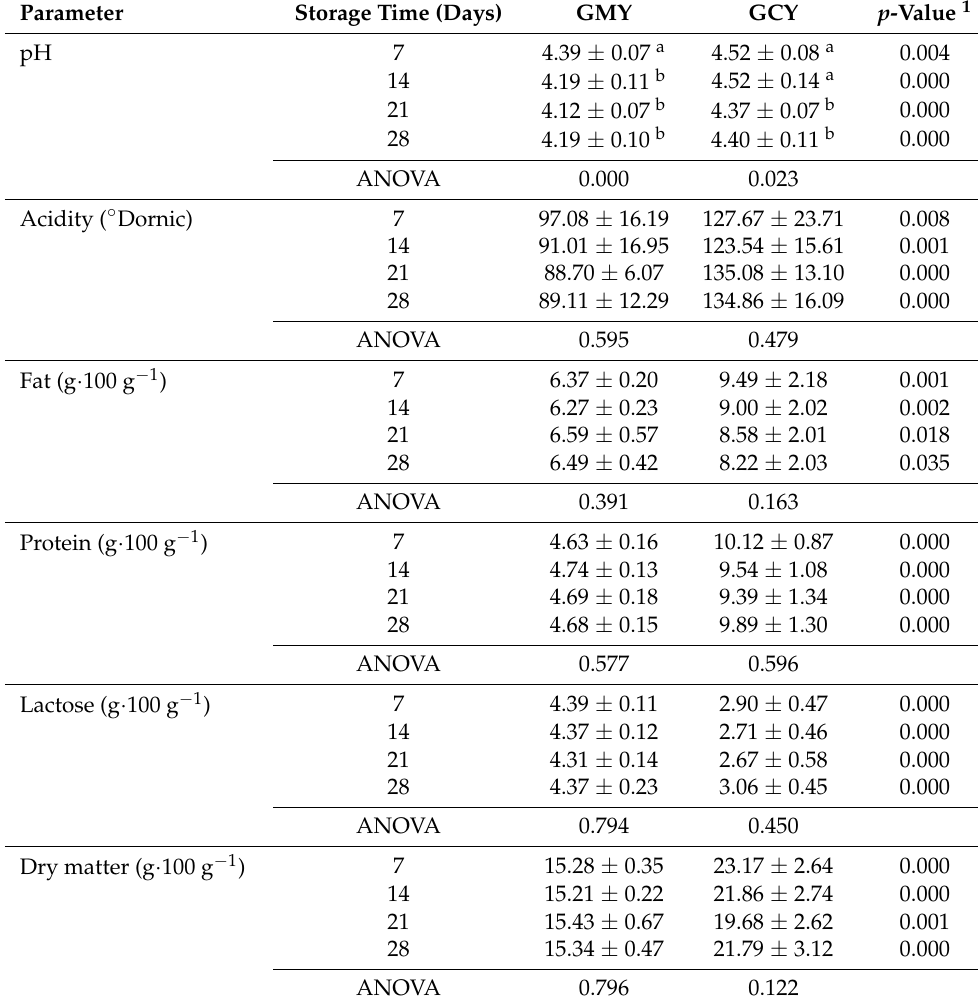
Table 3. Mean values ± standard deviation for pH, acidity, and chemical composition of goat milk yogurt (GMY) and goat colostrum yogurt (GCY) (n =